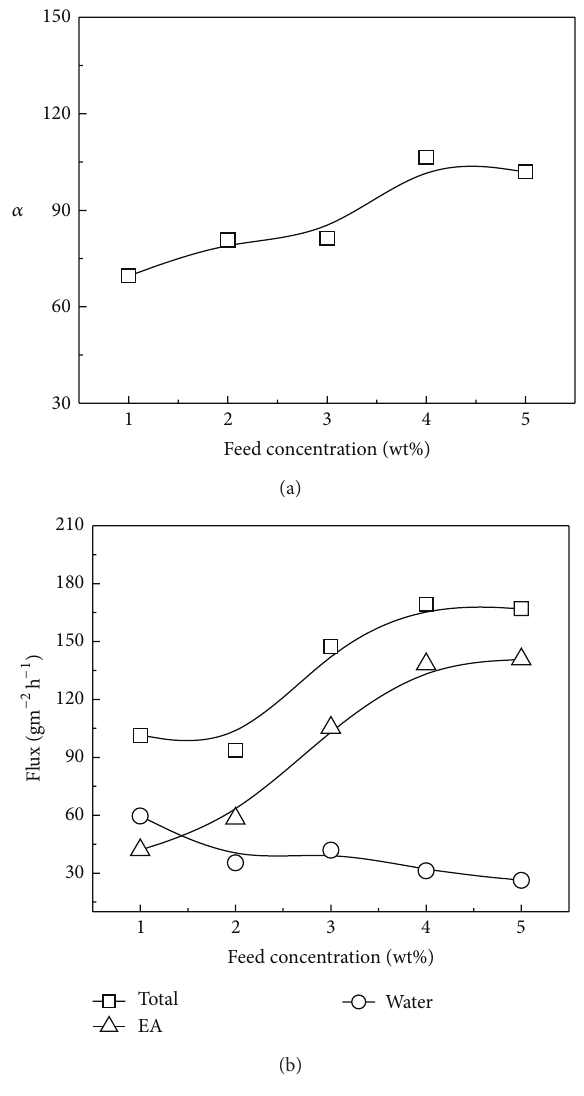
Figure 8: Effect of feed concentration on PV performance of PEBA/ZSM-5-10 membrane at 30 ∘ C: (a) separation factor and (b) permeation flux.